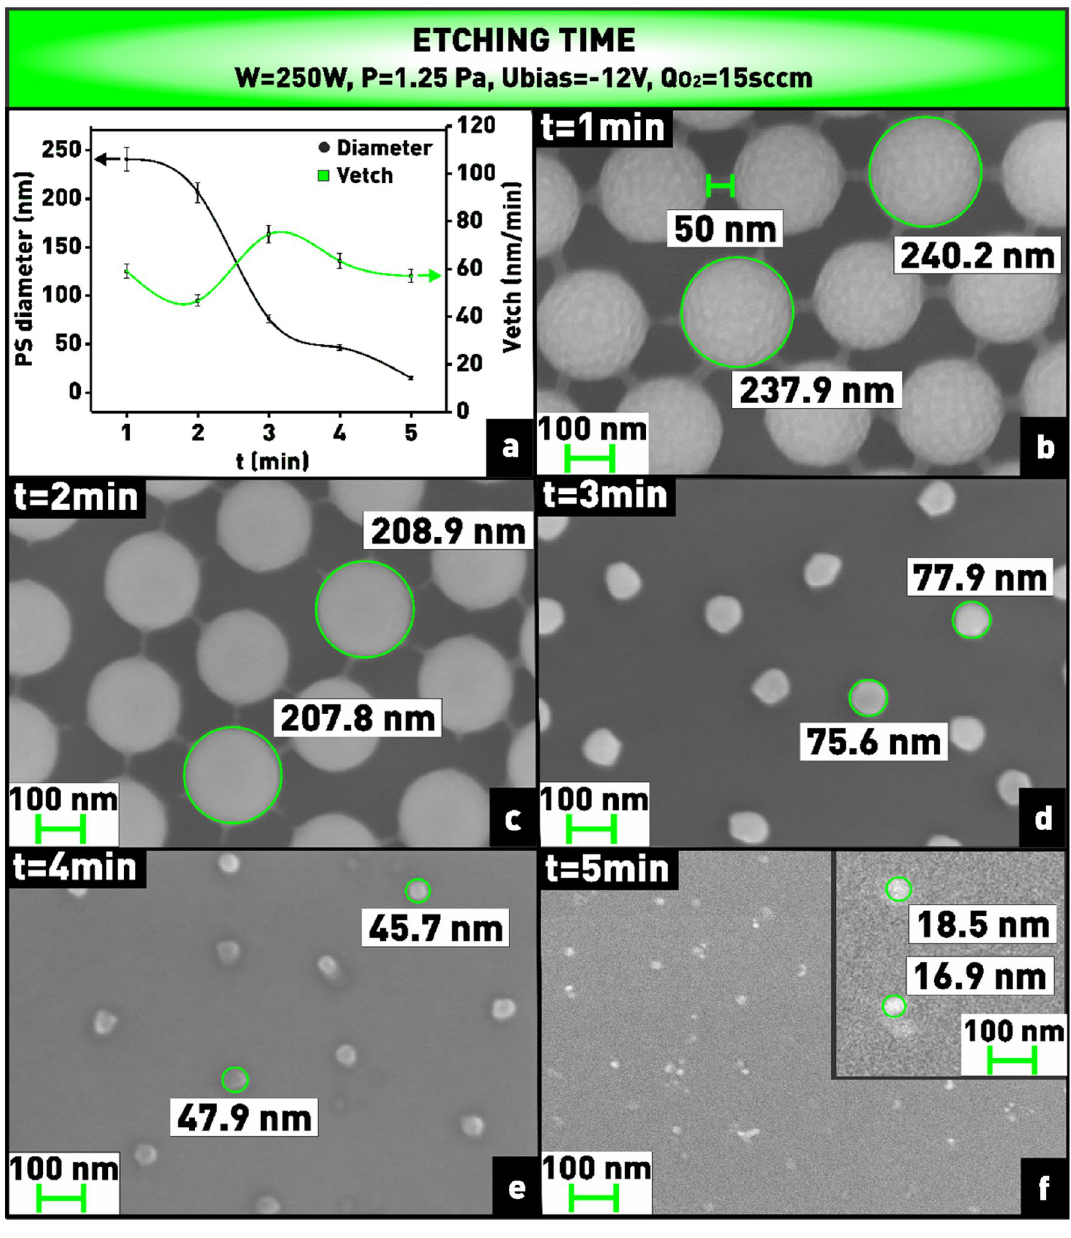
Figure 10. (a) Plot of dependence of nanosphere diameter and etching rate on etching time; (b–f) microphotographs of nanosphere mask obtained at varying etching